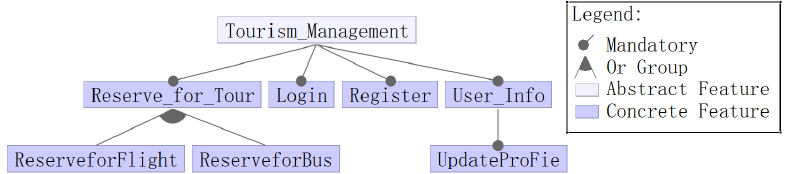
Figure 9. The selected